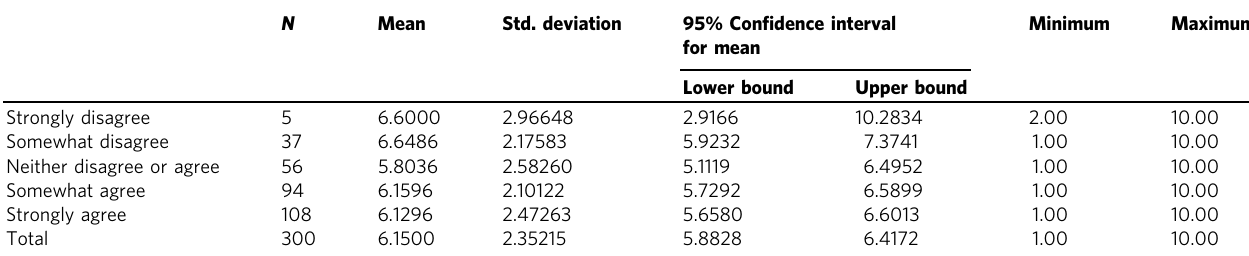
Table 2 Descriptive (undermine gatekeeping practices).